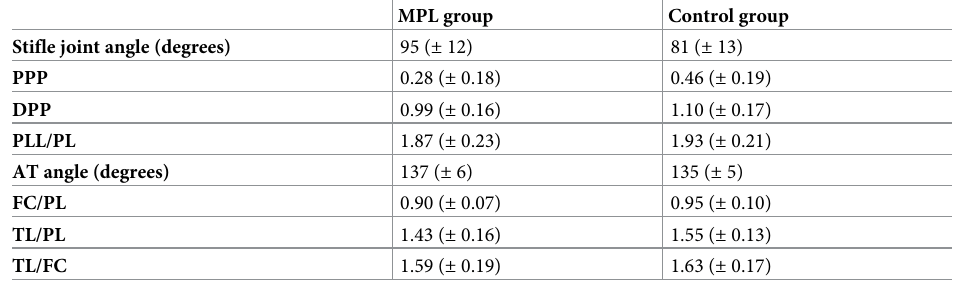
Abbreviations: AT angle, anatomical trochlear angle; DPP, distal patellar position; FC, craniocaudal size of the femoral condyle; PL, patellar length; PLL, patellar ligament length; PPP, proximal patellar position; TL, femoral trochlear length.